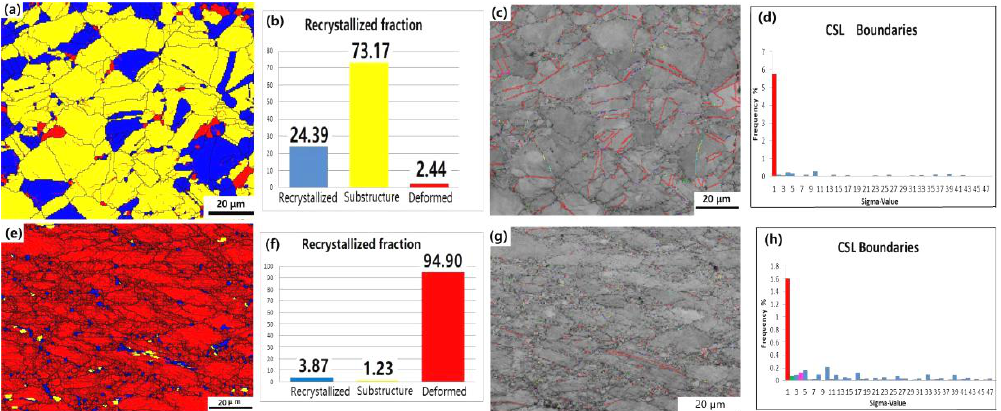
Figure 12. Sample microstructure at strain rate of 1 s −1 with a deformation temperature of 1373 K: ( a ) 20% height deformation image, ( b ) recrystallization ratio, ( c ) CSL image and ( d ) CSL distribution data. Sample microstructure at strain rate of 1 s −1 with a deformation temperature of 1323 K: ( e ) 40% height deformation image, ( f ) recrystallization ratio, ( g ) CSL image and ( h ) CSL distribution data.